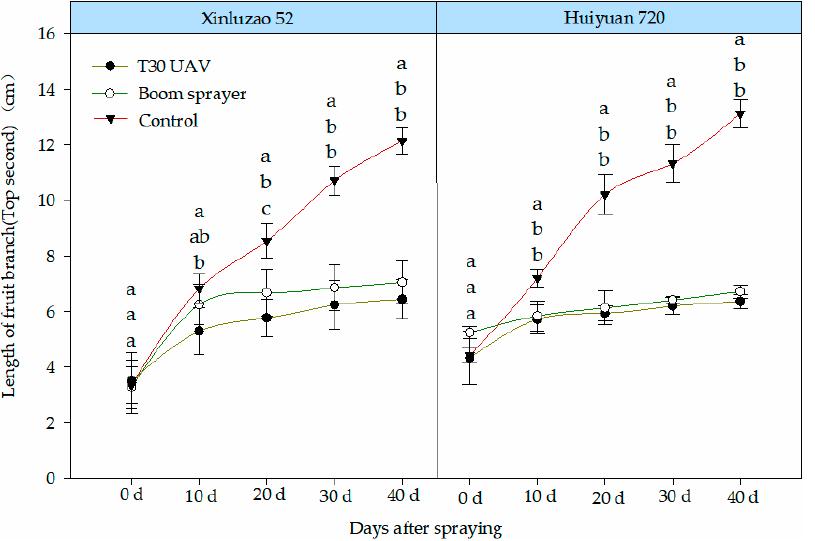
Figure 8. Effects of chemical topping agent sprayed by two sprayers on the length of fruit branches (top second). Different lowercase letters indicate significant differences between treatments at the 5% probability level ( p < 0.05).